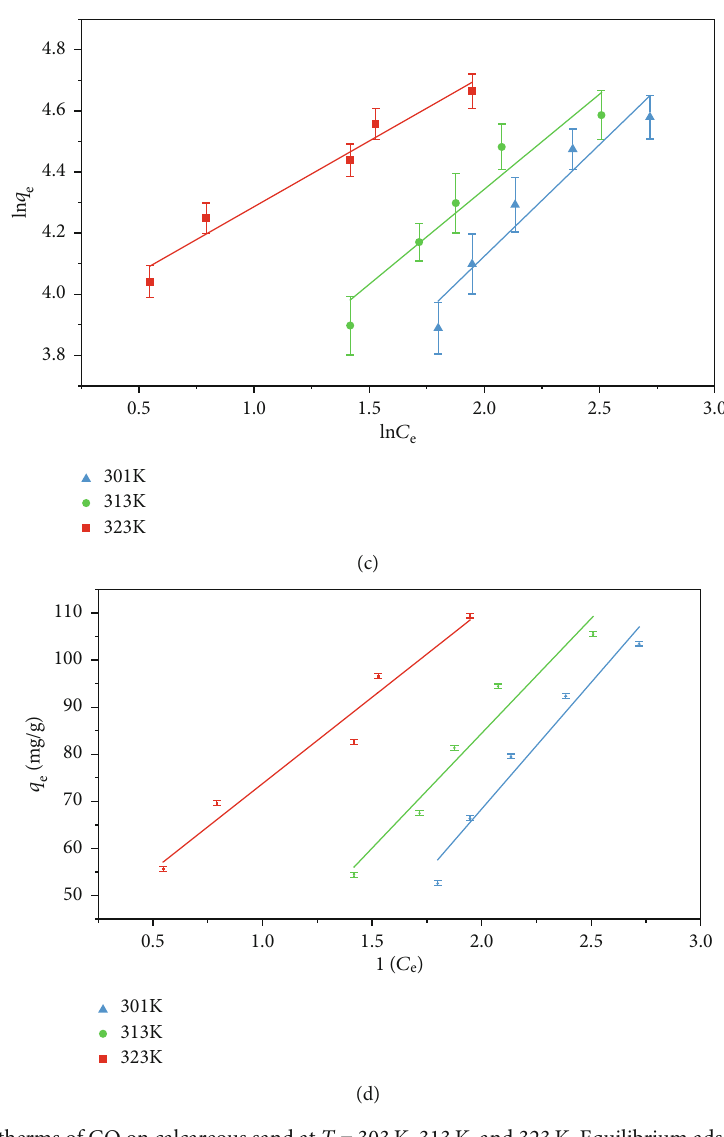
Figure 3: (a) Adsorption isotherms of GO on calcareous sand at T = 303 K , 313K, and 323K. Equilibrium adsorption isotherms fi tted by (b) Langmuir model, (c) Freundlich model, and (d) Temkin model. Table 1: Adsorption isotherm models